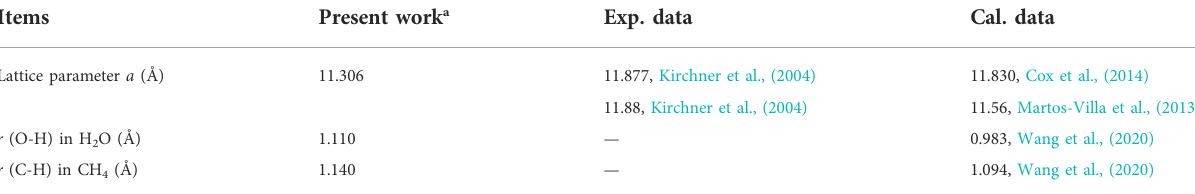
TABLE 2 Calculated results and previous data of sI-MH unit cell.